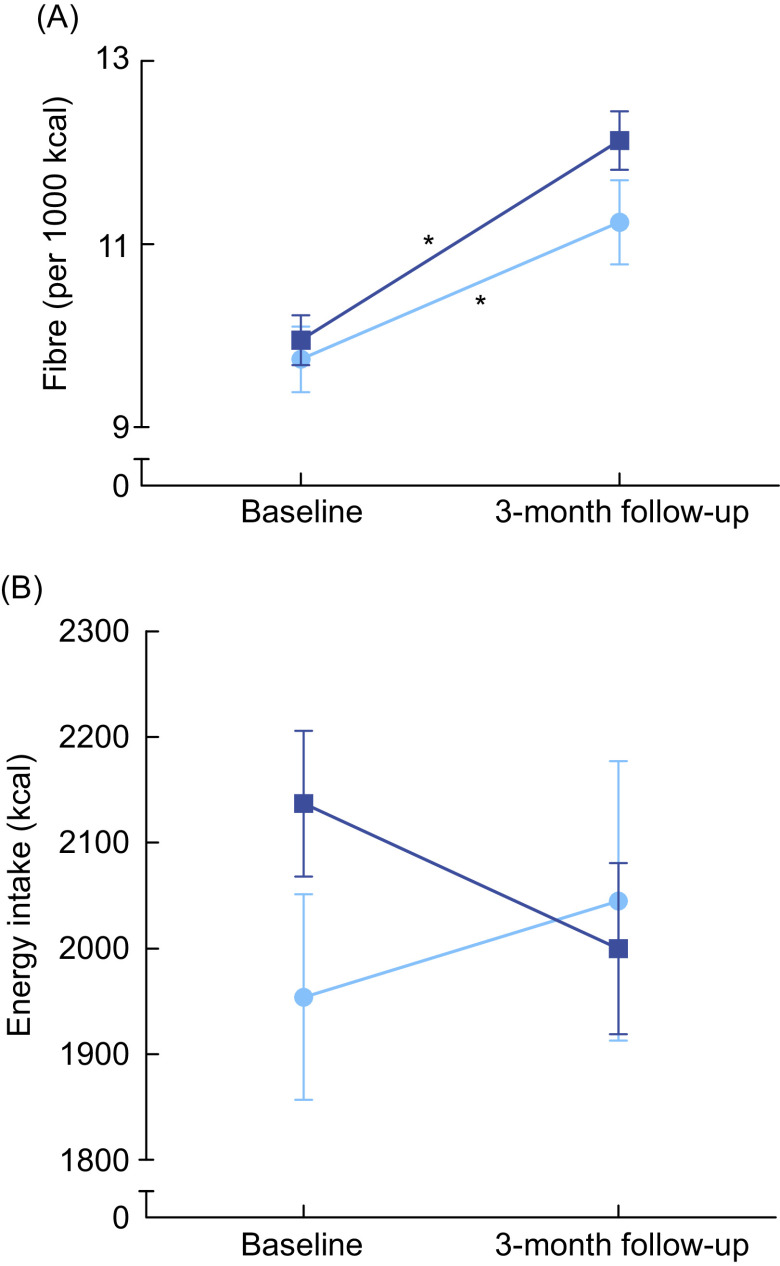
(A) Both groups increased dietary fibre intake at 3-month follow-up compared with baseline. (B) Visitors decreased their energy intake, non-visitors increased their energy intake (NS). Visitors are participants in the intervention group, and control participants who visited the personalised dietary advice (PDA) after the intervention, non-visitors are participants who never visited the PDA website. * Significant difference within the group. Error bars represent the standard errors. Data are based on the FFQ. , Non-visitors (n 26); , visitors (n 52)